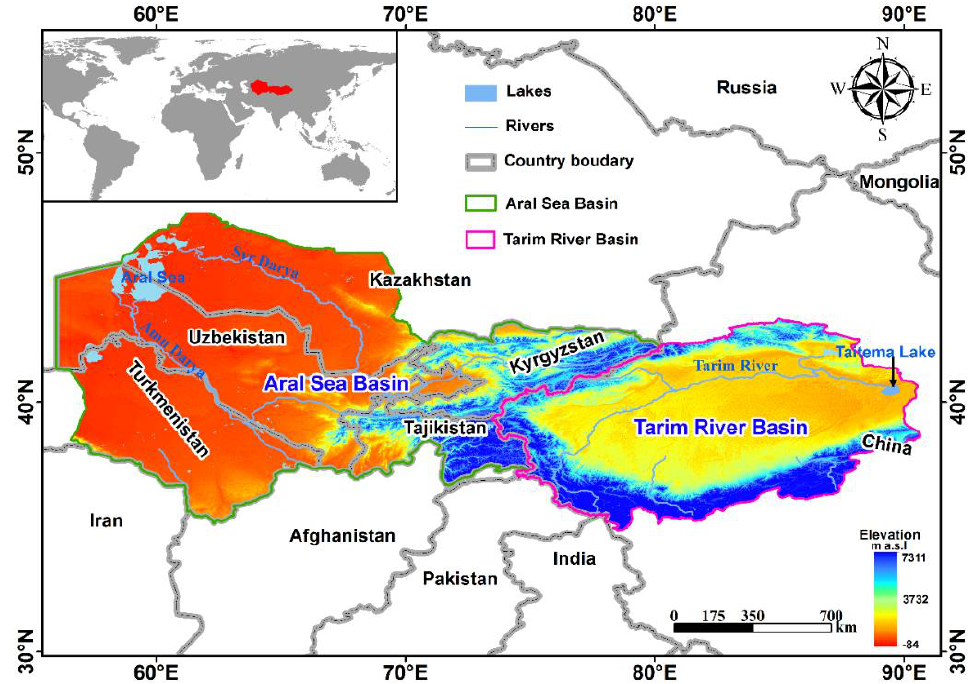
Figure 1. Map showing the locations of the Aral Sea Basin and the Tarim River Basin, Central Asia.